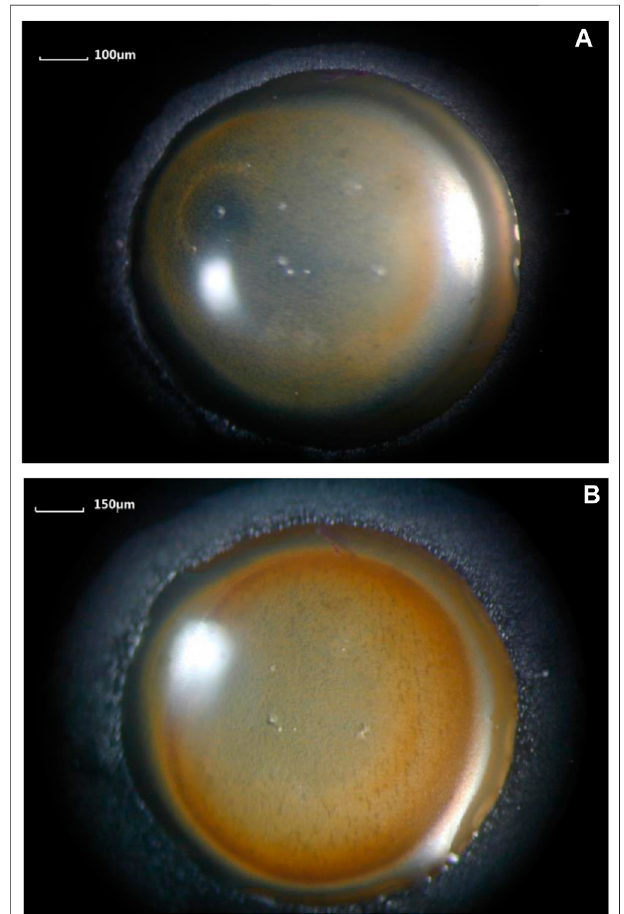
FIGURE 6 | Morphological observation of the primary droplet and microdroplets system at different elapsed times after dropping the primary droplet with an initial volume of 1.0 μ